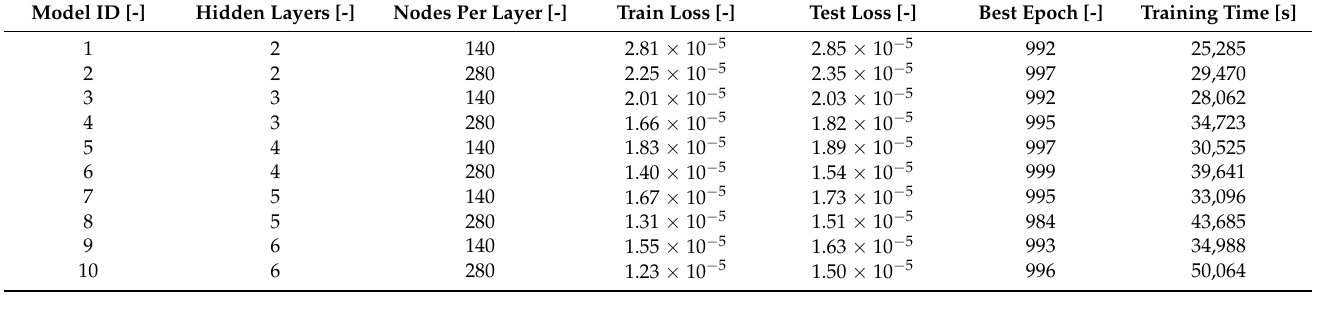
Table 6. Examples of loss function values and training times for some DFANN architectures. Nodes Per Layer Model ID [-] Hidden Layers [-] [-]